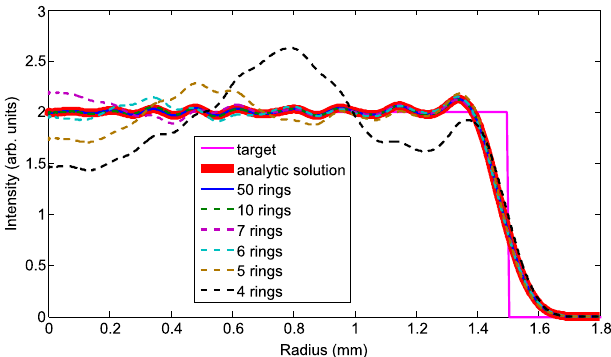
FIG. 11. Simulated output of a 3 mm diameter flattop assuming an ideal MMDM with analytic solution, or assuming the MMDM is composed of varied numbers of perfect actuator rings. The MMDM used in Fig. 10 is four-ring, with each ring being composed of multiple hexagonal